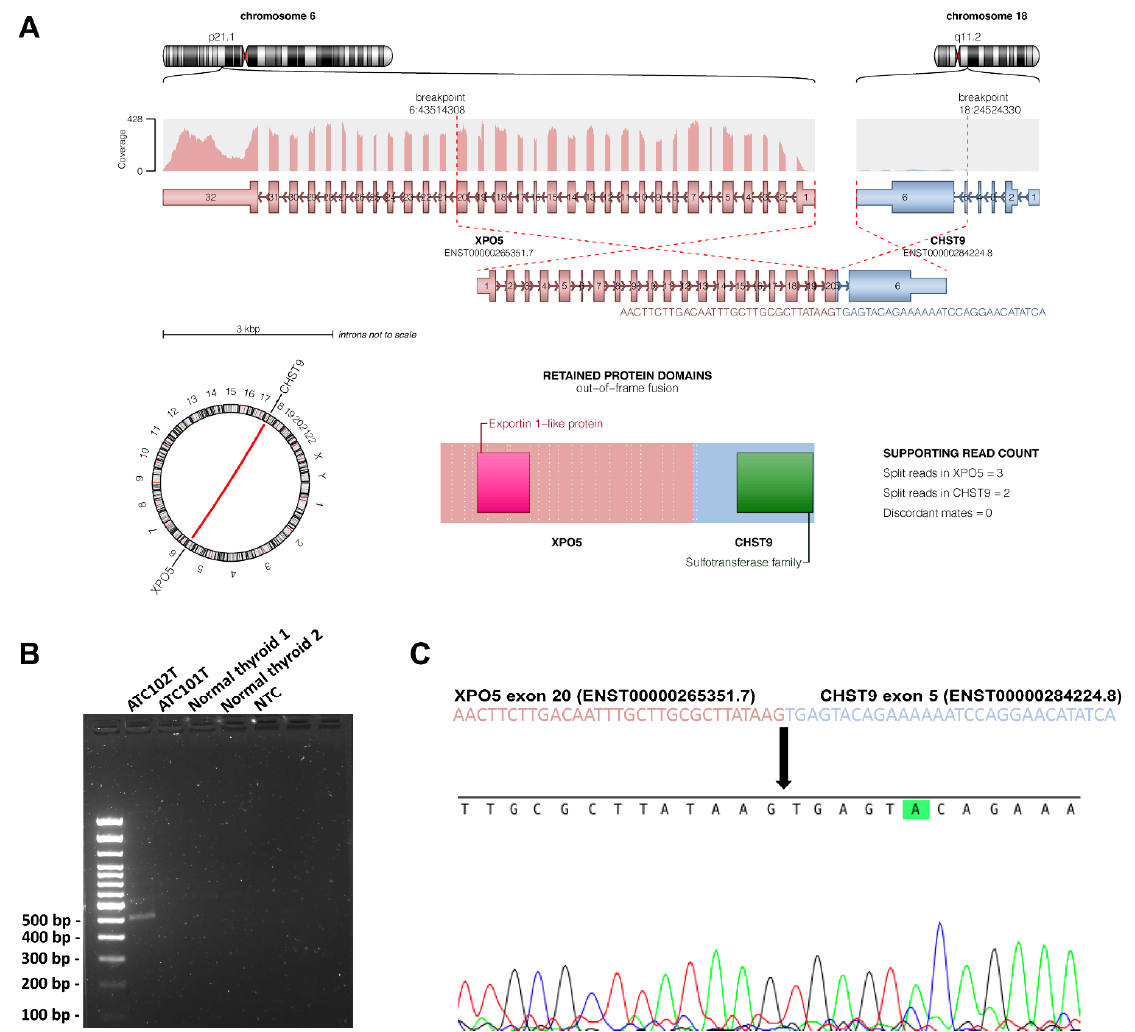
Figure 5. XPO5-CHST9 fusion gene validation. ( A ) Visualization of the chromosomal break points, with directions and exons annotated in the fusion gene. ( B ) Gel electrophoresis for validation of the fusion gene product in T102. T101 and two de-identified normal thyroid samples were used as negative controls. NTC; non-template control. ( C ) Sanger sequencing of the amplified fusion gene PCR product, verifying the fusion gene sequence. Arrow denotes the breakpoint.